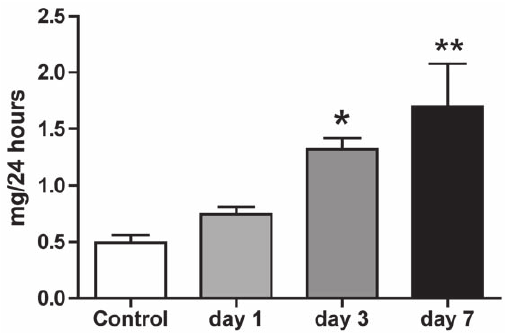
Figure 5. 24-hour urinary excretion of albumin. Urine was collected from conscious cyp1a1-Ren2 transgenic rats (n=8) maintained in individual metabolism cages, over consecutive days of transgene induction. Data are mean 6 SE. Statistical comparisons were made using ANOVA with Bonferroni post-test. **P , 0.01, *P , 0.05 versus the control